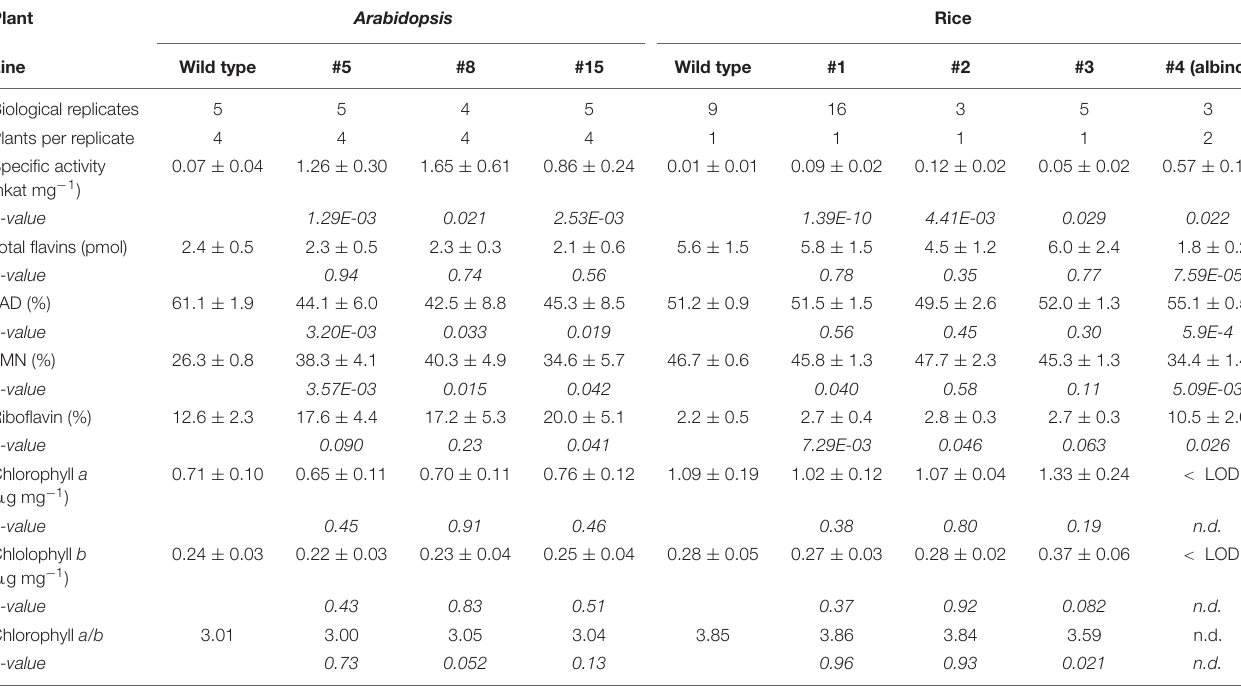
FIGURE 4 | Elevated nucleotide pyrophosphatase/phosphodiesterase (NPP) activity in transgenic plants. (A) Nucleotide pyrophosphatase/phosphodiesterase activity assayed as the production of FMN in the extracts from various tomato hairy root lines overexpressing ZmNPP and correlation to zeatin in vitro cis -to- trans conversion per 1 g of fresh weight (FW). (B) Activity of NPP (as the production of FMN) in the presence ( y -axis) and absence ( x -axis) of cis -zeatin in various tomato hairy root lines. The reaction was set up for each sample twice identically except of the presence/absence of cis -zeatin. (C) Relation of endogenous contents of FAD (circles), FMN (triangles) and riboflavin (squares) toward the activity of nucleotide pyrophosphatase/phosphodiesterase in 4-week-old Arabidopsis plants overexpressing ZmNPP . Samples were taken from four independent lines. Open and solid symbols represent wild type and transgenic lines, respectively. TABLE 2 | Characteristics of Arabidopsis and rice plants with altered nucleotide pyrophosphatase/phosphodiesterase activity. Plant Arabidopsis